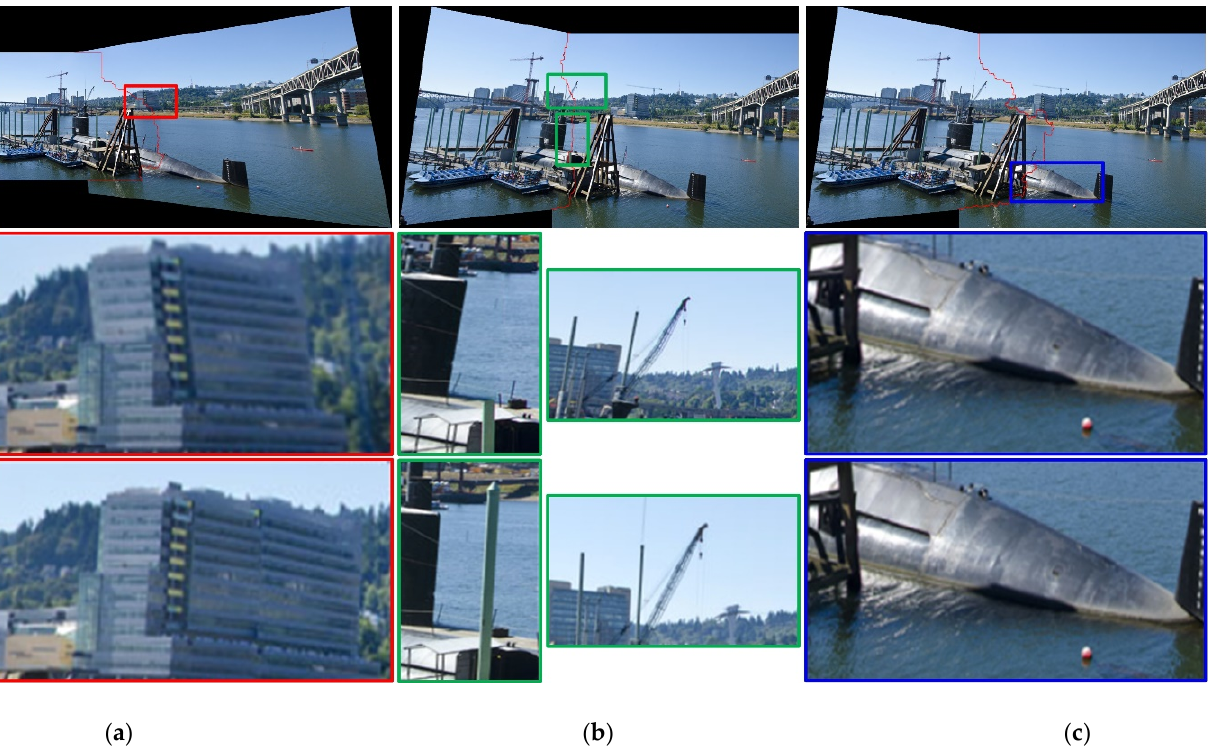
Figure 7. Comparison of three seam-driven methods and the used seams. ( a ) The perceptual seam-cutting method [18]. ( b ) The traditional seam-driven method based on color and texture information. ( c ) The proposed method. The first row shows the stitching results and the used seams with respective to the three different methods. The second row shows partial enlargements of the region through which the seam passes. The third row shows the partial enlargements of the region in the final stitched image of the SEAGULL dataset [17] which correspond to that shown in the second row. The third row is used as the comparison for the second row.